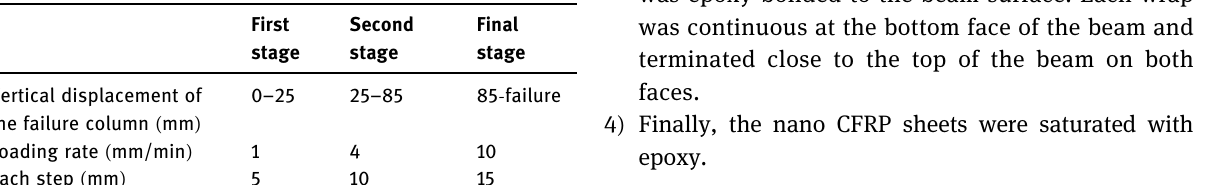
Table 1: Displacement control of the MTS actuator